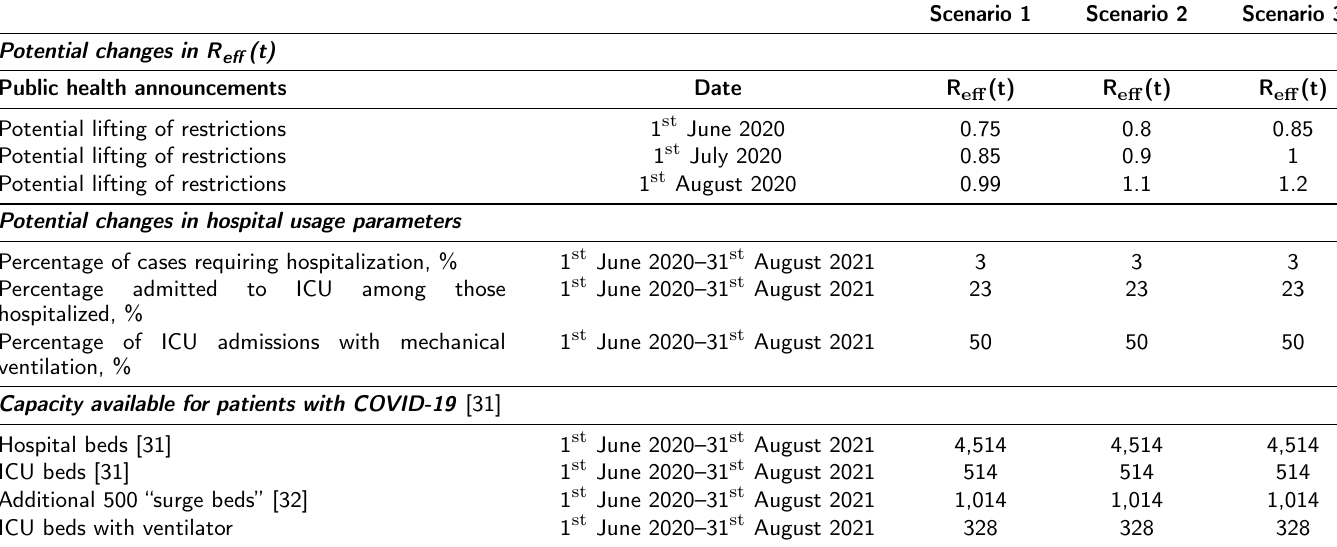
Table A3.3.1: Projection of the validation scenarios